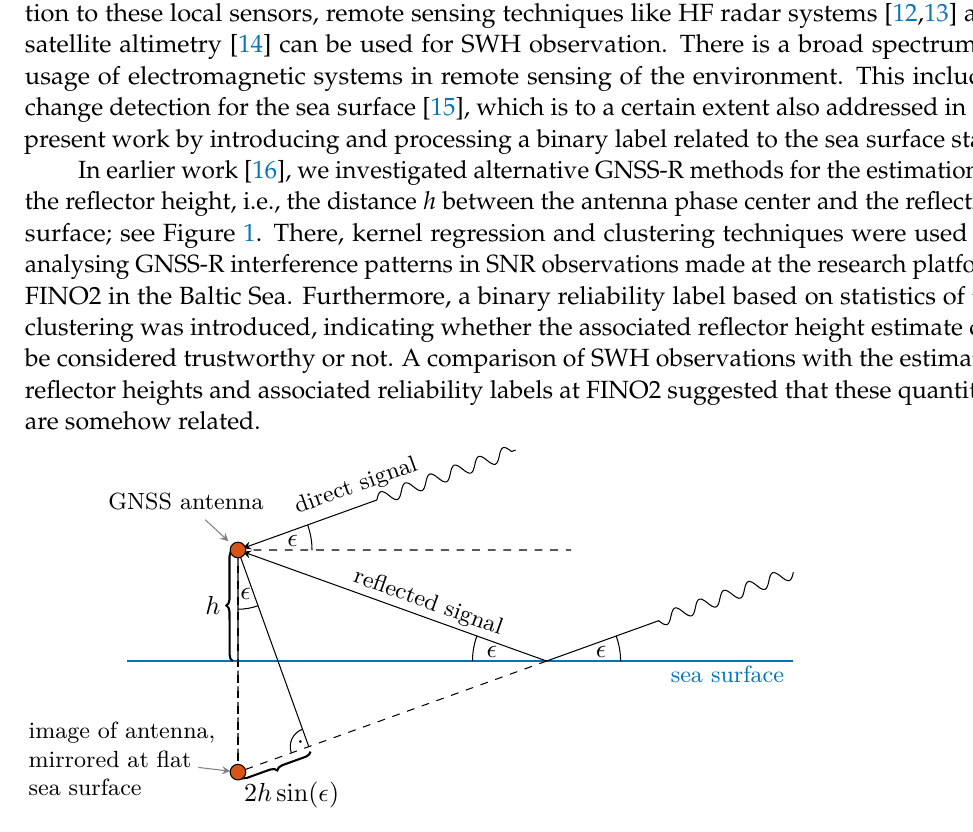
Figure 1. Schematic depiction of basic reflectometric scenario; see [17]. (cid:101) is the elevation angle of the satellite emitting the signal and h the reflector height. The delay between direct and reflected signal amounts to 2 h sin ( (cid:101) )